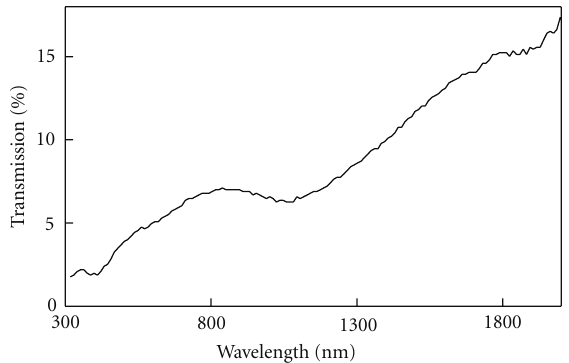
Figure 6: Optical transmission of the CTSO film deposited under condition 1 for 5 min.